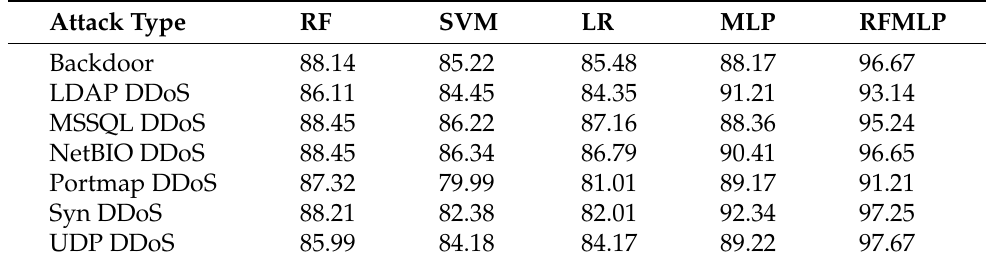
Table 8. Accuracy of classifiers on STIN terrestrial dataset.